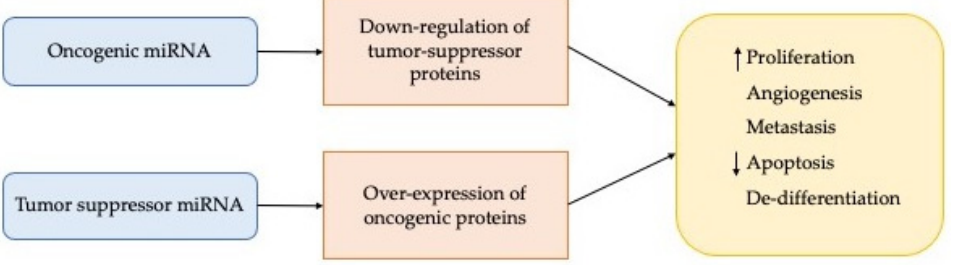
Figure 2. Main effects of deregulation of the miRNA expression.